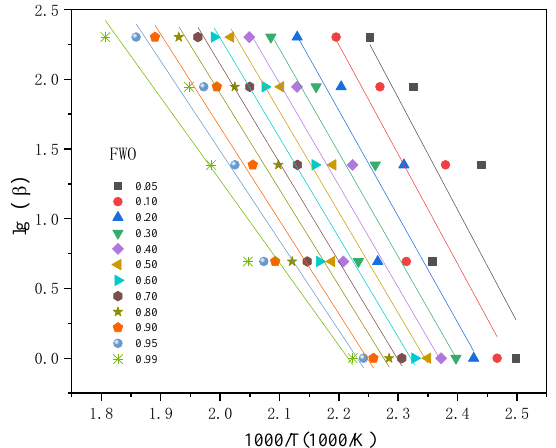
Figure 5. E a plots of Starink model at different β in DSC experiments for the LiTFSI-LiODFB elec- trolyte.